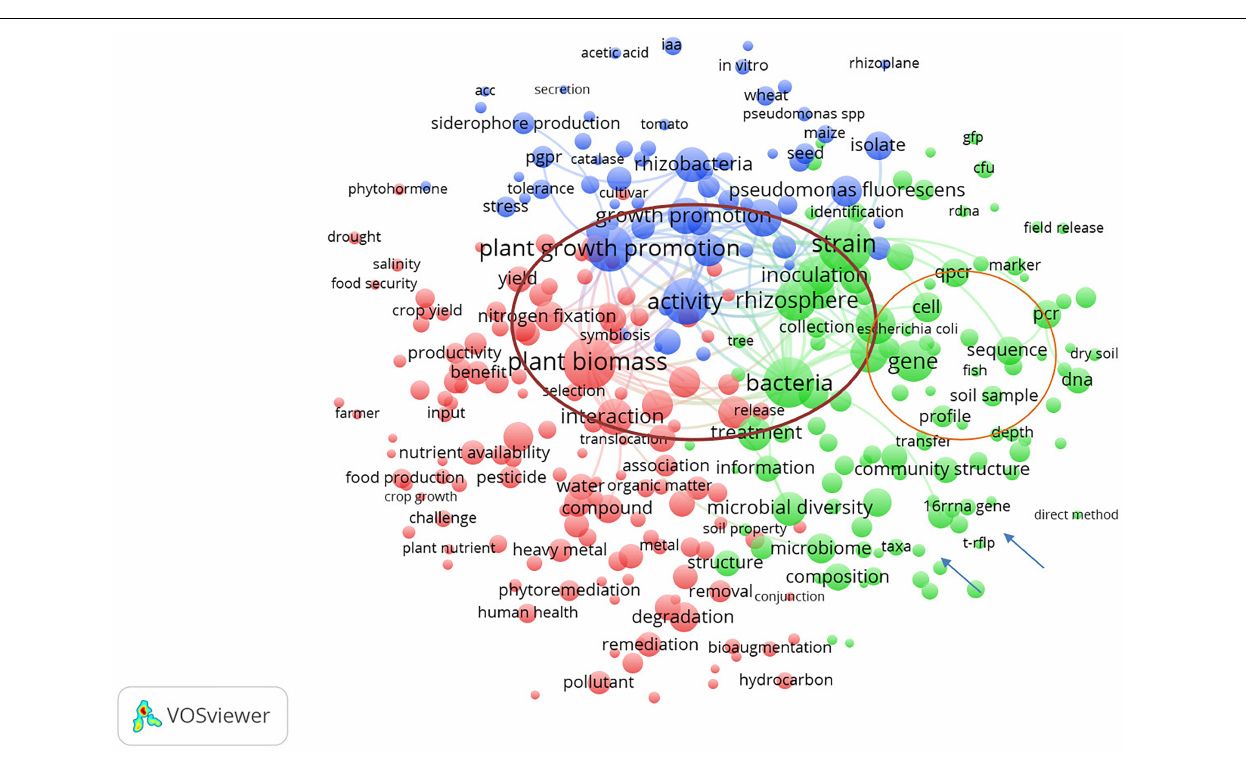
FIGURE 2 | The terms clustering map based on the analysis of publications concerned with soil microbial inoculants tracking and monitoring retrieved from Scopus database from the period 1991–2020. Red, blue, green colors represent the terms belonging to different clusters. The dot size of each term is based on the number of its occurrence. The connecting lines indicate the 100 strongest co-occurrence links between